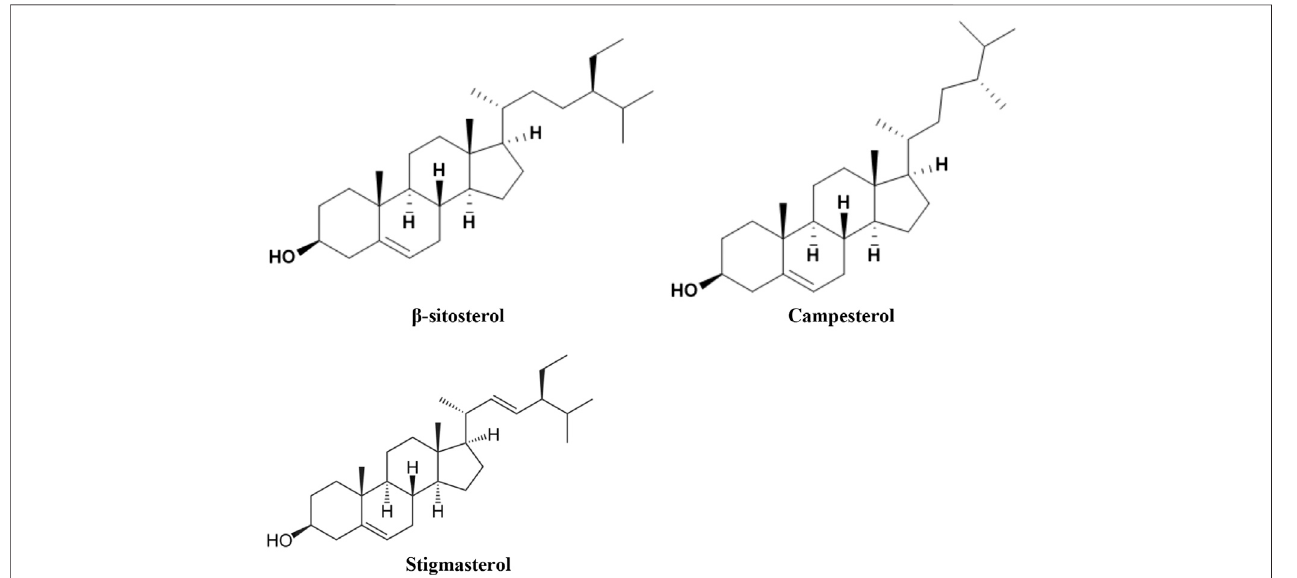
FIGURE 2 | The structure of the most occurring plant-originated sterols in human